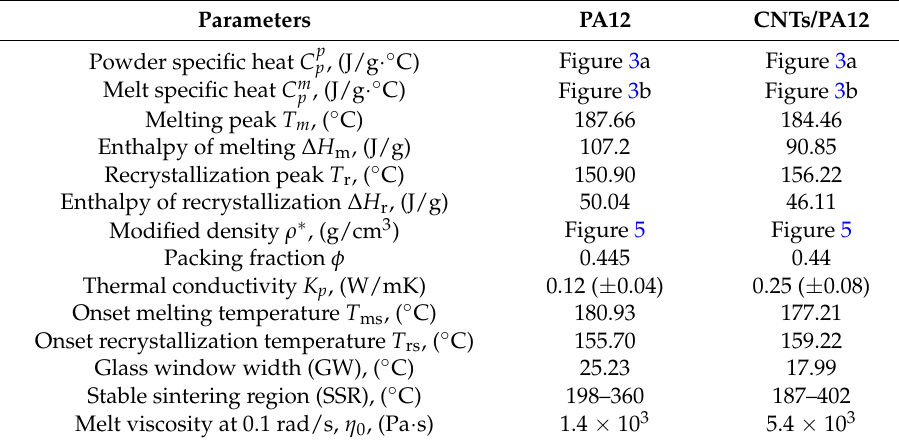
Table 3. Material parameters for PA12 and CNTs/PA12 powders.